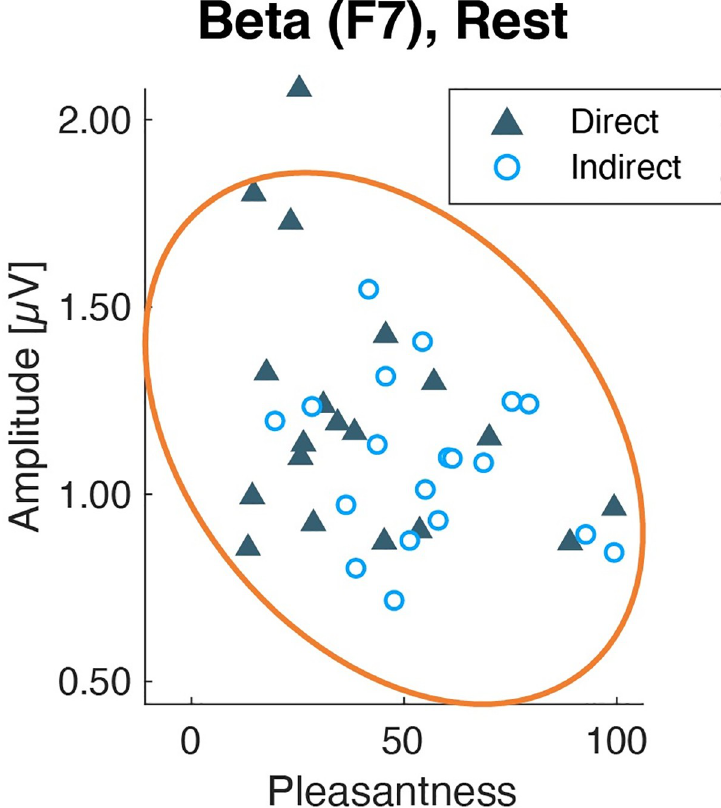
Fig 15. Scatter plots of each subjective assessment and beta amplitudes at F7 during rest. Yellow lines show the 95% density ellipse. Each point indicates individual mean data across three repetitions.